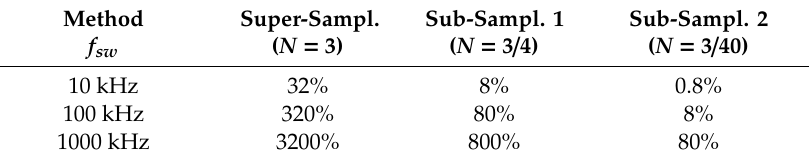
Table 1. Digital signal processor (DSP) utilization of each sampling